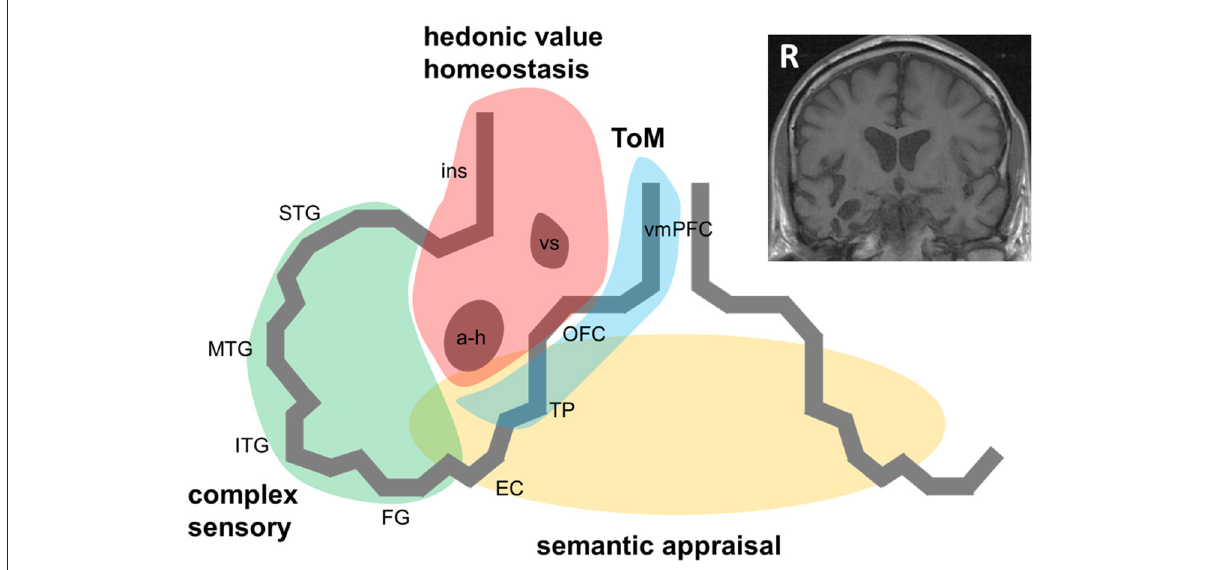
FIGURE1 A pathophysiological schematic of the syndrome of right temporal lobe atrophy. The Figure diagrams key brain regions, networks and cognitive processes implicated in the pathogenesis of the syndrome of right temporal lobe atrophy (RTLA). The main cartoon is oriented following radiological convention with the right temporal lobe projected on the left, as in the inset coronal T1-weighted structural brain MRI section (derived from a patient with a clinical syndrome of RTLA). We argue that the clinical syndrome of RTLA reflects the intersection of four large-scale neural networks in the anterior, inferior and mesial right temporal lobe, each mediating a cognitive process that is core to the expression of the RTLA syndrome: complex sensory analysis (green); homeostasis and assignment of hedonic value (red); semantic appraisal of sensory signals (gold); and inference about and response to others’ mental states, mentalising or ‘theory of mind’ (blue). Note that each of these networks extends beyond the right temporal lobe, to the left temporal lobe and beyond. The cognitive processes mediated by these networks interact extensively; these interactions are likely to fundamentally underpin the diverse phenotypic repertoire of RTLA. Although the core functional neural circuit lesion of RTLA has not been defined, a plausible candidate (relevant to all the cognitive operations schematised here) is impaired neural template-matching (see text). a-h, amygdala and hippocampus; EC, entorhinal cortex; FG, fusiform gyrus; ins, insula; ITG, inferior temporal gyrus; MTG, middle temporal gyrus; OFC, orbitofrontal cortex; R, right; STG, superior temporal gyrus; ToM, theory of mind; TP, temporal pole; vmPFC, ventromedial prefrontal cortex; vs, ventral